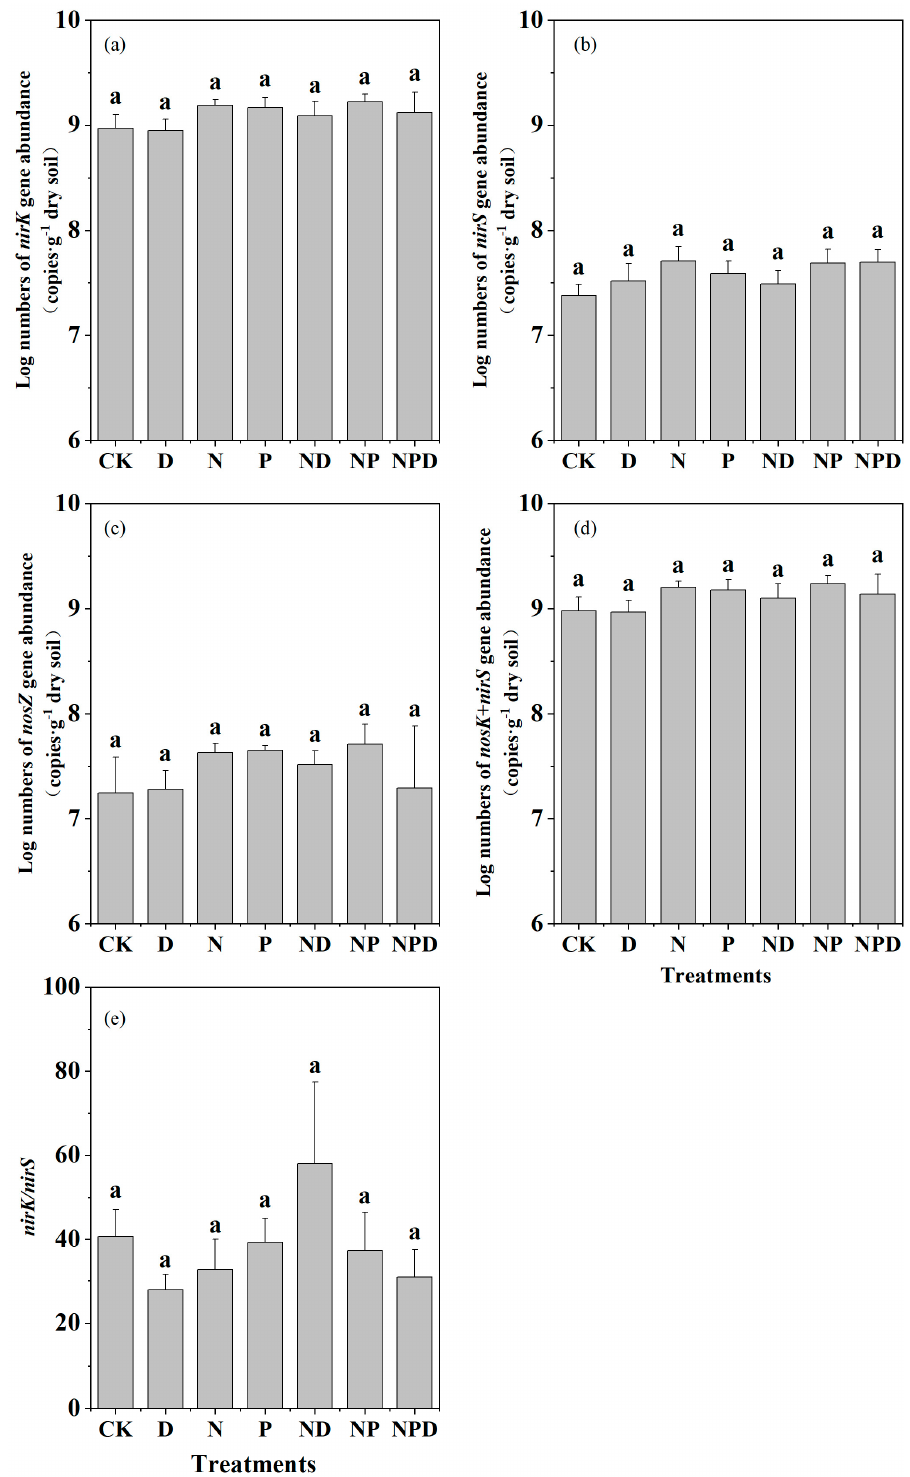
Figure 2. Effects of different treatments on the abundances of the ( a ) nirK gene; ( b ) nirS gene; ( c ) nosZ gene; ( d ) nirK gene + nirS gene; and ( e ) nirK / nirS . Note: Data are presented as the mean ± SE (n = 4). Different letters above boxplots indicate significant differences ( p < 0.05) between treatments. Treatments: control (CK), drought (D), nitrogen addition (N), phosphorus addition (P), nitrogen and drought combined (ND), nitrogen and phosphorus combined (NP), and nitrogen, phosphorus, and drought combined (NPD).